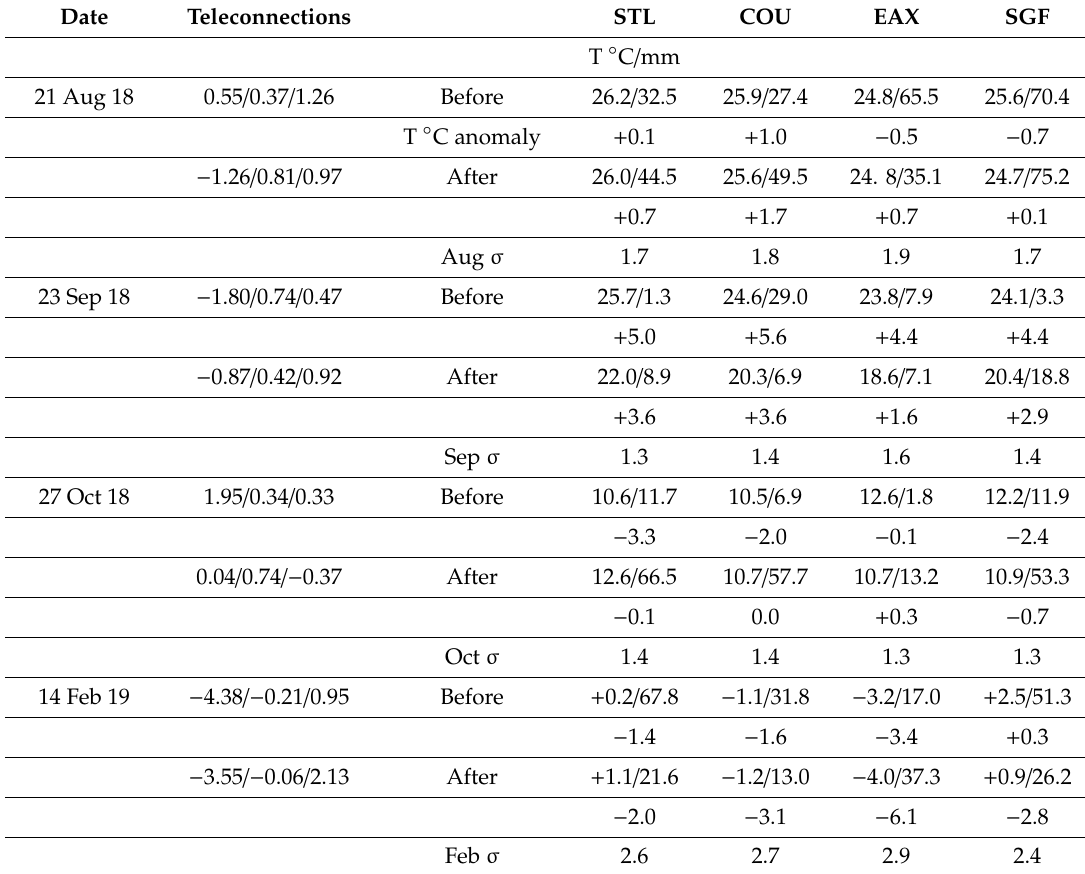
Table 4. The date of an observed NH IE maximum. Moreover, the major NH teleconnection indexes (PDO / NAO / AO), and the temperature (T ◦ C) and precipitation (mm) character for Saint Louis, Missouri (MO) (STL), Columbia, MO (COU), Kansas City, MO (EAX), and Springfield, MO (SGF) for the ten days before and after the observed IE maximum. The temperature anomalies and the monthly standard deviation ( σ ) relative to the 1981–2010 means are also listed (see: